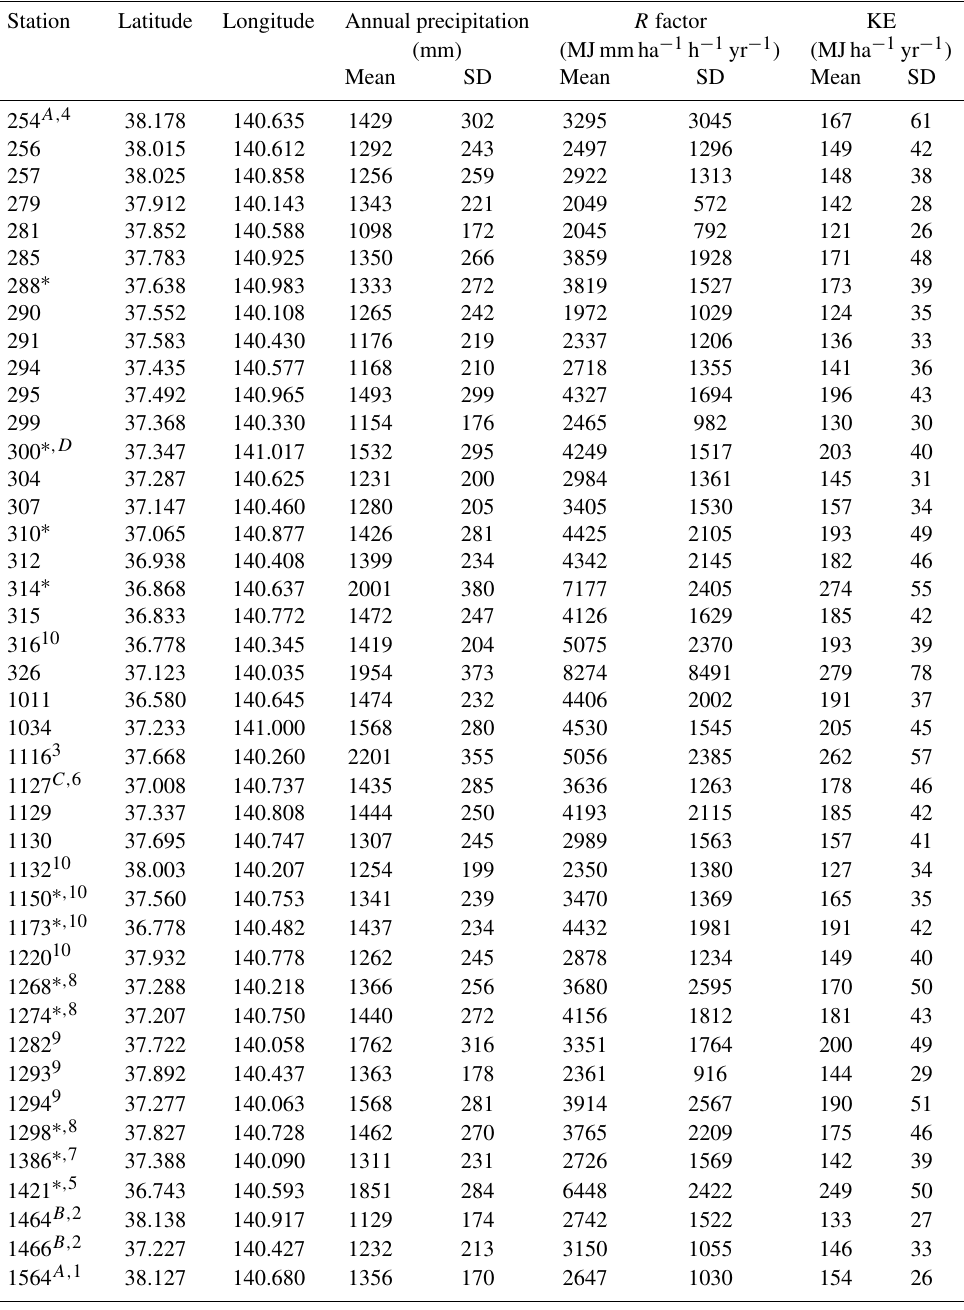
Table 1. Station coordinates along with the mean and standard deviation (SD) of annual precipitation, R factor and kinetic energy (KE).